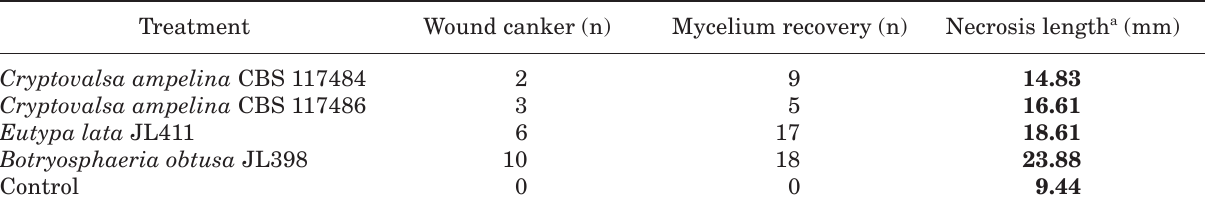
Table 2. Pathogenicity of Cryptovalsa ampelina on one-year old grapevine plants cv. Macabeu ( n =18). Data on Eu- typa lata and Botryosphaeria obtusa included for comparison